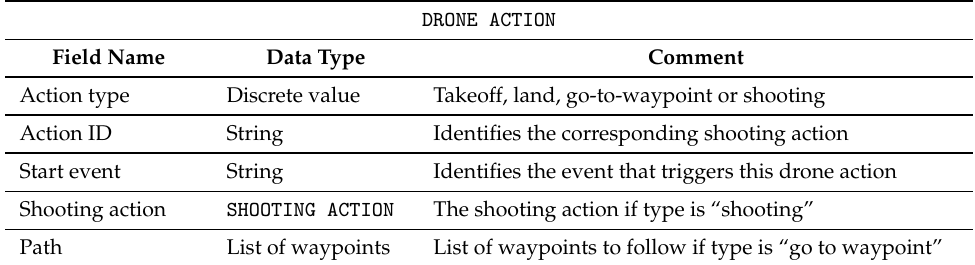
Table 3. Structure for the data type DRONE ACTION